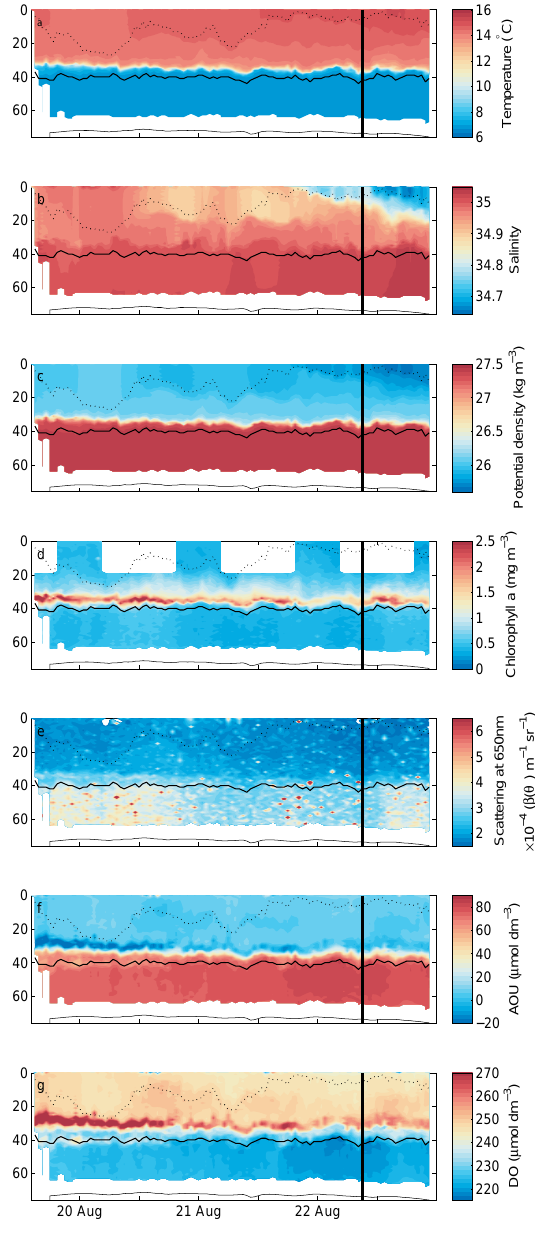
Figure 3. Seaglider section of temperature ( a ; ◦ C), salinity ( b ; PSU), potential density ( c ; kgm − 3 ), chlorophyll a concentra- tion ( d ; mgm − 3 ), optical scattering as a volume scattering function at 650nm ( e ; × 10 − 4 β(θ c ) m − 1 sr − 1 ), apparent oxygen utilization ( f ; µmoldm − 3 ) and oxygen concentration ( g ; µmoldm − 3 ) sampled along the transect. Bathymetry as detected by the onboard altimeter is indicated along the bottom. Daytime chlorophyll a values show- ing signs of quenching are blanked. The vertical black line indicates the transition to a different water mass; data after this vertical black line are excluded from the oxygen calculations. The solid black con- tour indicates the 7 ◦ C isotherm. The dotted black contour indicates the mixed layer depth ( σ > 0.01kgm − 3